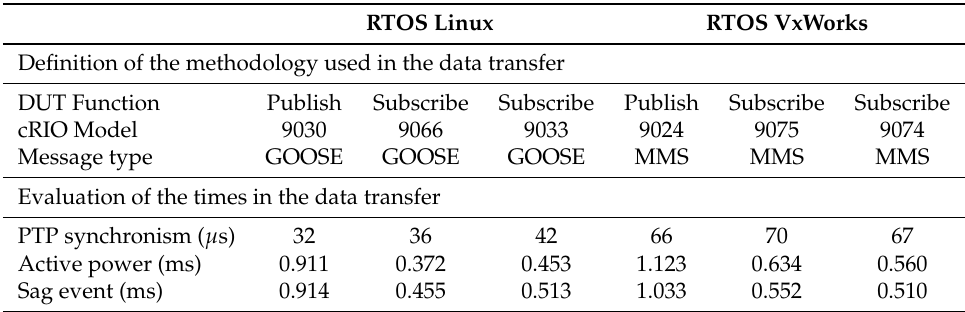
Table 2. Results for data transfer between devices under test (DUT). RTOS: Real-Time Operating System. RTOS Linux RTOS VxWorks